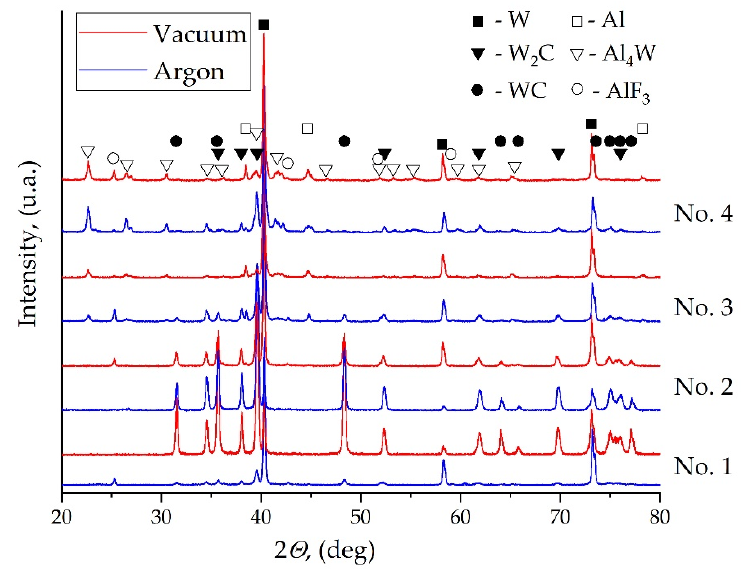
Figure 10. XRD patterns of the products (of compositions No.1–4) synthesized from the W/PTFE/Al specimens.